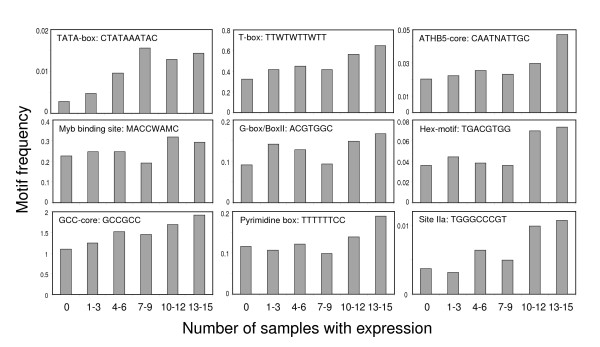
Motifs with enrichment in transcribed TE-related gene promoters. Genes were grouped according to the number of samples that show transcriptional activity. Enrichment was measured as the frequency of a motif in gene promoters of a certain group. TE, transposable element.